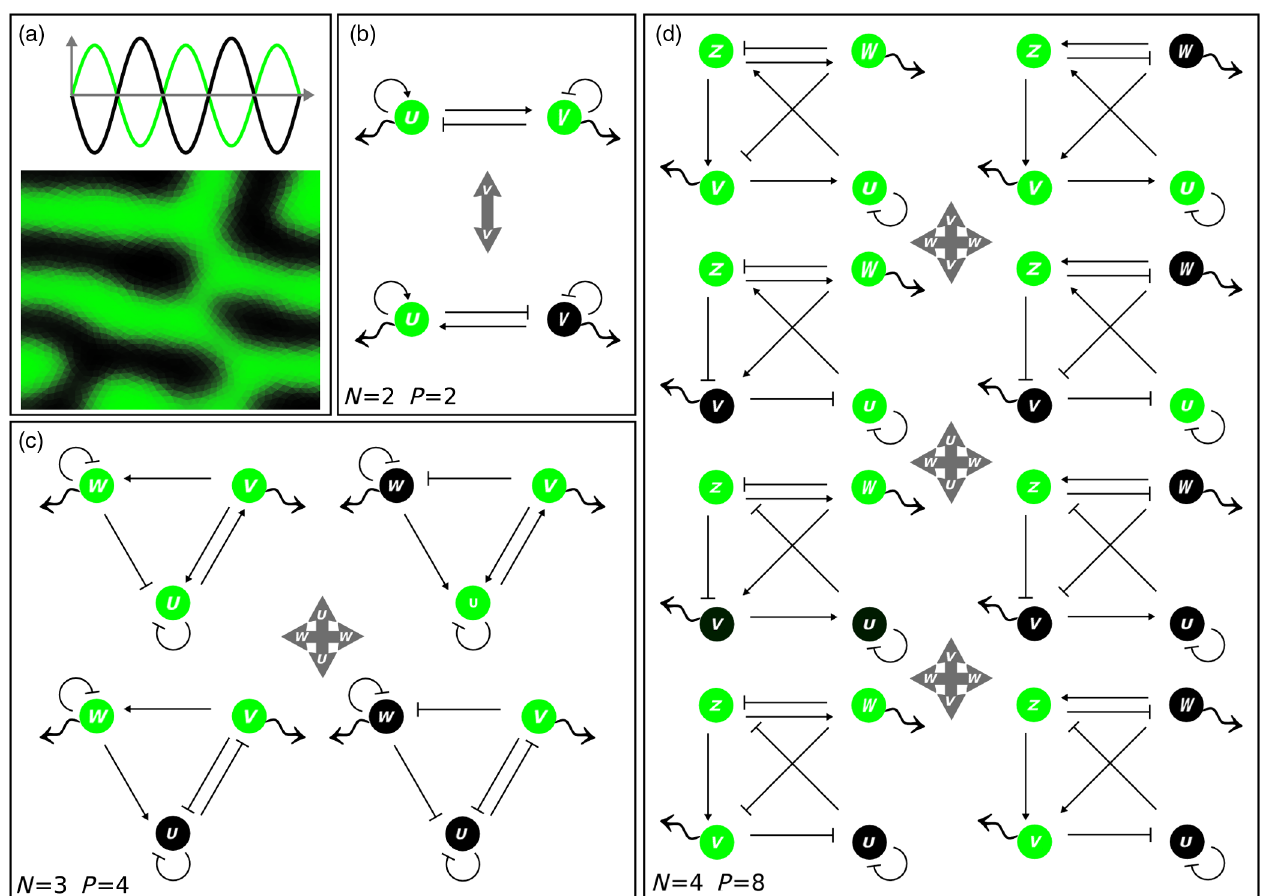
FIG. 6. (a) The concentration of any pair of species in a Turing pattern can be in phase or out of phase. (b) There are two two-node Turing networks, the activator-inhibitor network (top), where the species are in phase, and the substrate-depleted network (bottom), where the species are out of phase. In general, there are 2 N − 1 ways to group N species in two phases of a Turing pattern. An N -node topology allows us to construct 2 N − 1 different Turing networks by switching the signs of the incoming and outgoing edges of one particular node at a time, leaving the cycle signs invariant. Each network makes one of the patterns. Grey cursors indicate that the signs of the edges going in and out of a node have been switched, producing a change in phase. Nodes with the same color are in the same phase. (c),(d) Illustration of this principle for example topologies of N ¼ 3 and N ¼ 4 nodes, which generate P ¼ 4 and P ¼ 8 networks and